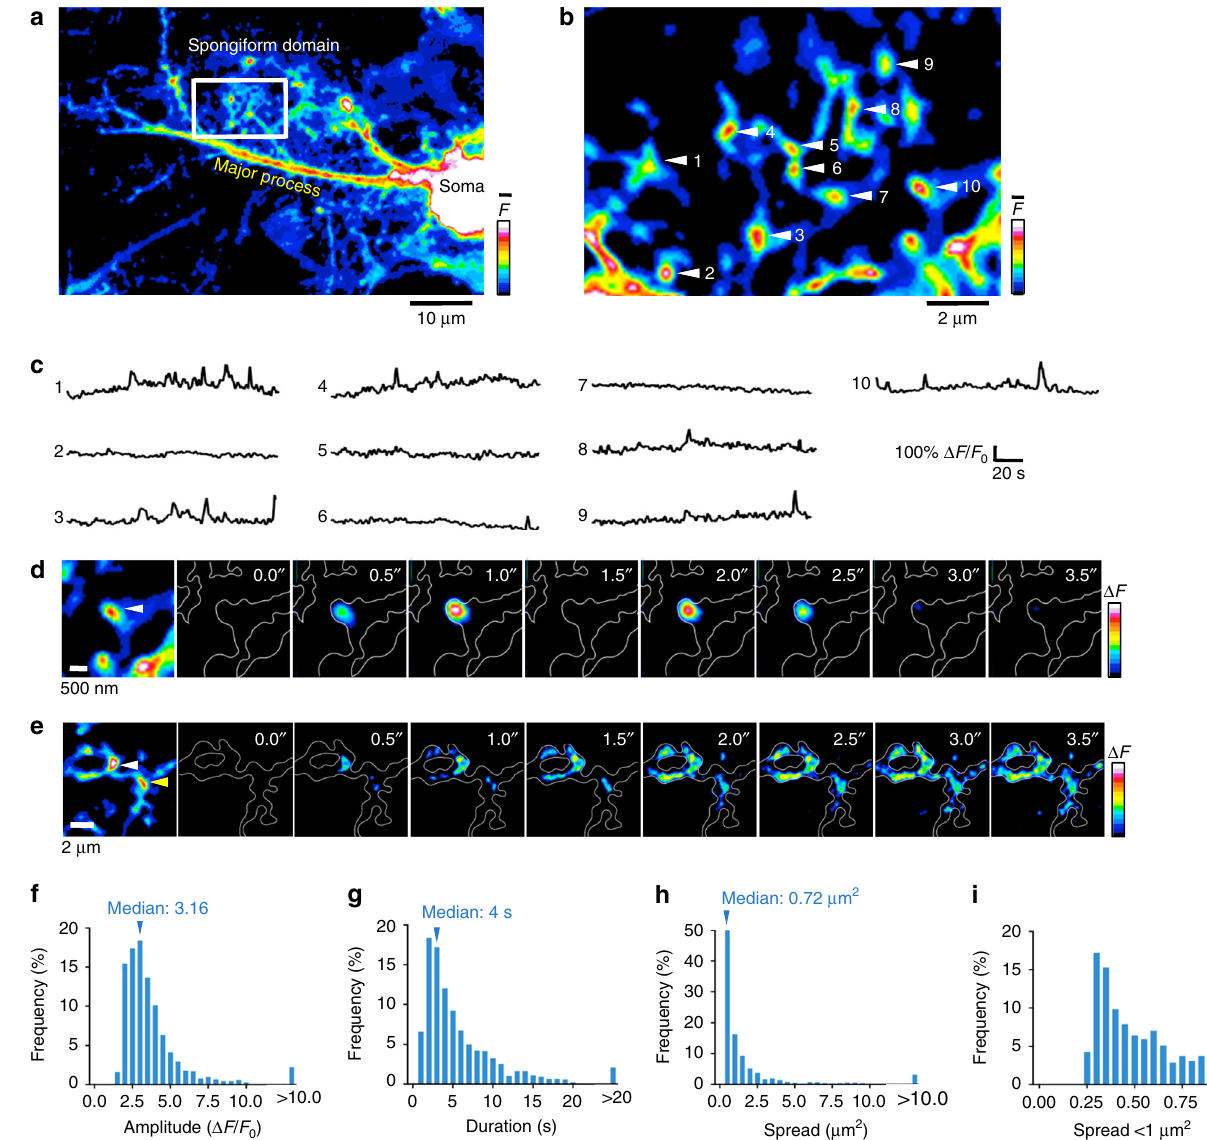
Fig. 6 Astrocytic nodes exhibit microdomain Ca 2 + signals. a A confocal overview image of a GCaMP6s-expressing astrocyte. b A zoom image of a box in ( a ). ROIs were manually placed on typical nodes. The general anatomical layout of shafts and nodes are still recognizable in confocal images. Nodes typically appear as bright spots at branch points. c Spontaneous Ca 2 + traces from ROIs shown in b , showing that each node exhibits unique pattern of Ca 2 + signals. d Time-lapse images of Ca 2 + events, which were spatially restricted to a single node (right), and the corresponding confocal image of the structure where node is indicated with a white triangle (left). e Time-lapse images of a Ca 2 + event, which originated at a node and spread via the connecting shafts to a neighboring node (right), and the corresponding confocal image of the structure where the originating node is indicated with a white triangle and neighbor node is indicated with a yellow triangle (left). f Frequency distribution of amplitude of Ca 2 + events ( n = 1583 events from 5 slices). g Frequency distribution of duration of Ca 2 + events ( n = 1583 events from 5 slices). h Frequency distribution of spread of Ca 2 + events. In 59% of the events, the spread was less than 1 µ m 2 ( n = 1583 events from 5 slices). i Frequency distribution of spread of Ca 2 + events under 1 µ m 2 , suggesting that the majority of Ca 2 + events in the spongiform domain were con fi ned to local domains corresponding to single nodes ( n = 941 events from 5